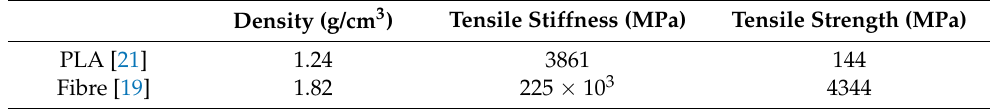
Table 1. Raw material, PLA and fibre,